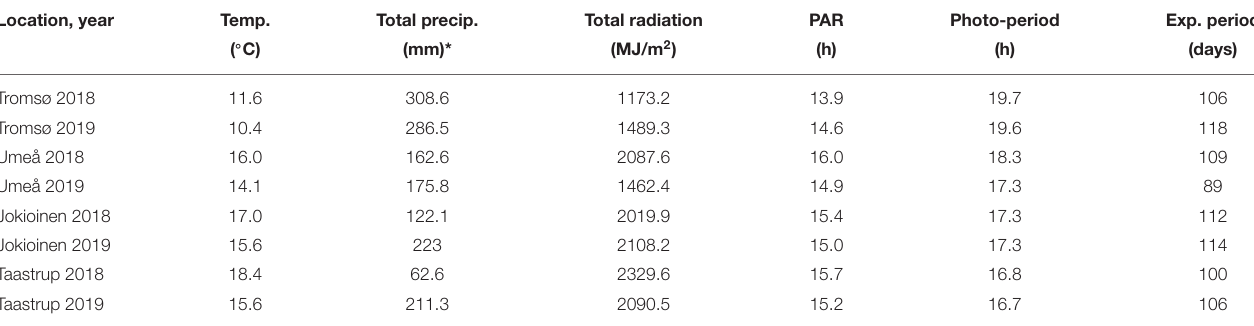
TABLE 4 | The average temperature, total precipitation, total global radiation, average daily photosynthetic light period (PAR), and the average photoperiod during the field trials in 2018 and 2019. Location, year